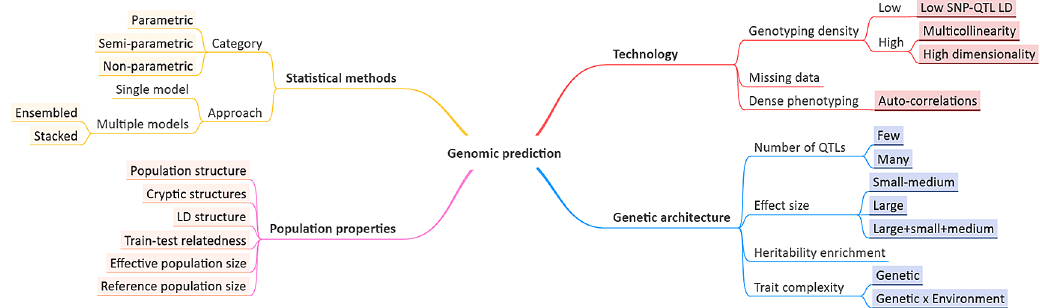
Figure 1.Genomic predictioncharacteristics. Factors affectinggenomic prediction performance,often measured as correlation between true phenotype values and those predicted by a